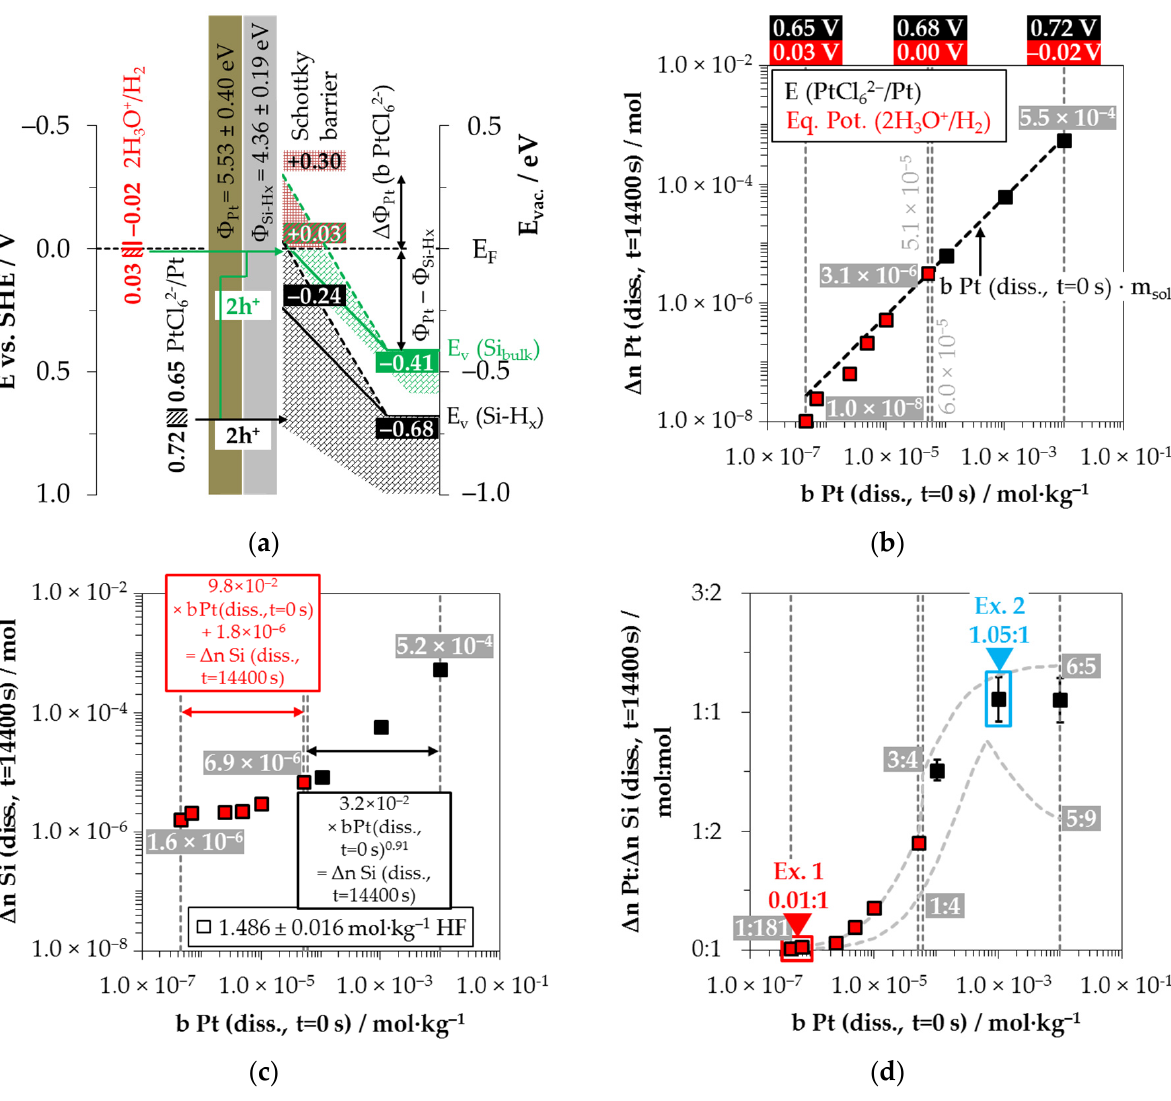
Figure 10. ( a ) Energy diagram of PtCl 62 − and H 3 O + reduction at the Pt/Si contact with the indication of the upper and lower limits of the redox strengths of the PtCl 6 2 − /Pt half-cell [95] and those of the equilibrium potentials of the 2H 3 O + /H 2 half-cell [33], and energetic levels of the valence bands of the bulk and hydrogen-terminated silicon ( E V (Si bulk ) [26,80,81], E V (Si-H x ) [82]) and their bending, based on the differences of Φ Pt and Φ Si-Hx [83–88] and the findings from [26]; ( b ) amounts of Pt deposition ( Δ n Pt ( diss., t = 14,400 s)) and ( c ) Si dissolution ( Δ n Si ( diss., t = 14,400 s)), as well as stoichiometric ratios of ( d ) Pt deposition and Si dissolution ( Δ n Pt: Δ n Si ( diss., t = 14, 400 s)) relative to the initial PtCl 62 − molality b Pt ( diss., t = 0 s); Δ n H 2 ( g, t = 14,400 s) < 1.8 × 10 − 6 mol in each case.